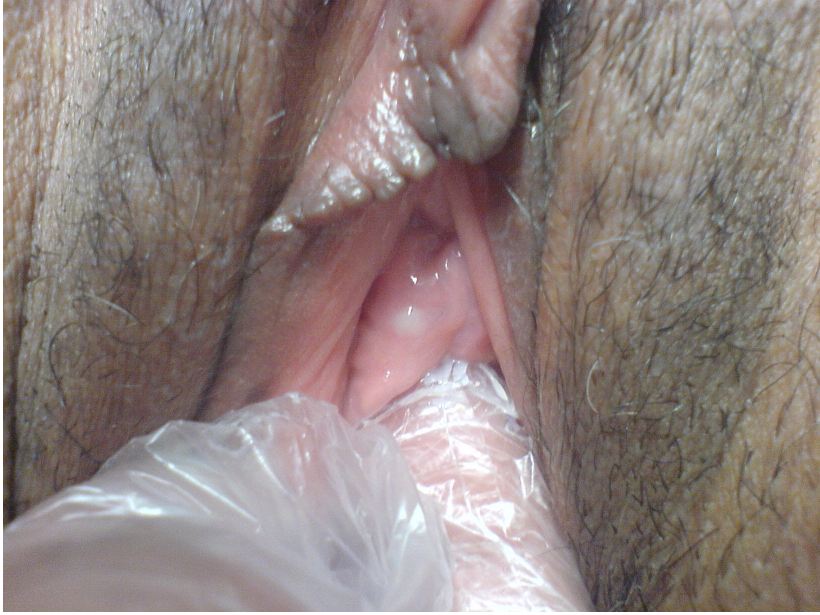
FIGURE 1 . Local compression at the left vaginal wall, showing purulent discharge at the topography of the left Skene’s gland